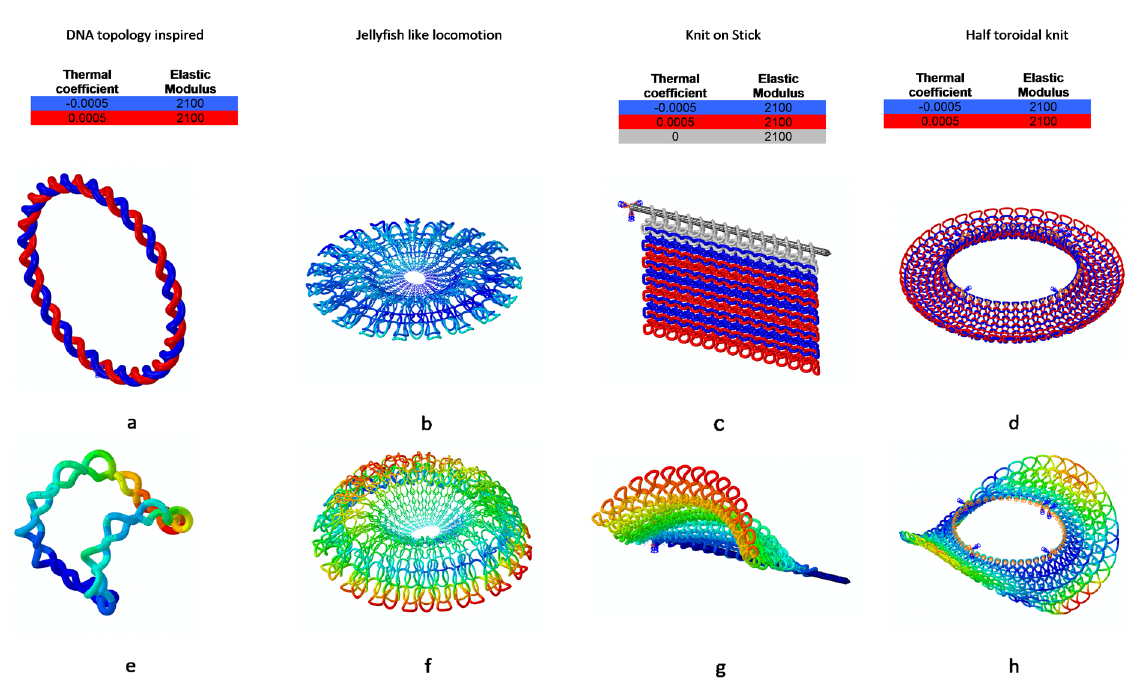
Figure 4. Distortion of various shapes with programmed material –Geometric and Material properties and final morphed structure. ( a ) Initial structure of checkerboard pattern with edges along y constrained. Insert shows a single loop highlighted in red, which is then patterned linearly to complete a single yarn. Linearly repeating yarn is shown in yellow. Geometric coordinates of the smallest repeating unit shown in red for the yarns corresponding to the insert in previous row. ( b ) Material coding for checkerboard pattern. ( c ) Final morphed structure of the checkerboard pattern. ( d ) Initial structure of plate with waves pattern of high-volume fraction. Insert shows a single loop highlighted in red, which is then patterned linearly to complete a single yarn. Radially repeating and scaled yarn is shown in yellow. Geometric coordinates of the smallest repeating unit shown in red for the yarns corresponding to the insert in previous row. ( e ) Material coding for pattern with waves. ( f ) Final morphed structure of plate with waves. ( g ) Initial structure of inverted cone. Insert shows a single loop highlighted in red, which is then patterned linearly to complete a single yarn. Radially repeating and scaled yarn is shown in yellow. Geometric coordinates of the smallest repeating unit shown in red for the yarns corresponding to the insert in previous row. ( h ) Material coding for inverted cone. ( i ) Initial structure of inverted cone. ( j ) Initial structure of plug. Insert shows a single loop highlighted in red, which is then patterned linearly to complete a single yarn. Radially repeating and scaled yarn is shown in yellow. Geometric coordinates of the smallest repeating unit shown in red for the yarns corresponding to the insert in previous row. ( k ) Material coding for plug. ( l ) Final morphed structure of plug. ( m ) Initial structure of wind turbine blade. Insert shows a single loop highlighted in red, which is the patterned linearly. Circumferentially repeating yarn is shown in yellow. Geometric coordinates of the smallest repeating unit shown in red for the yarns corresponding to the insert in previous row. ( n ) Material coding for Wind turbine blade. ( o ) Final morphed structure of the wind turbine.